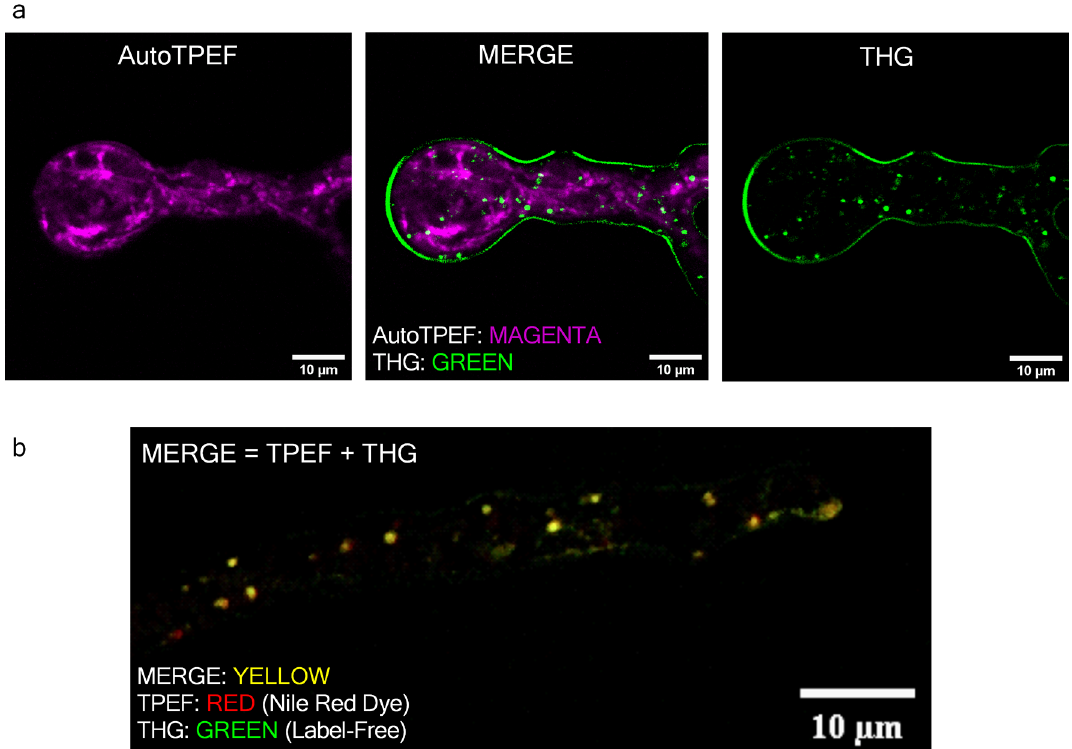
Figure 4. TPEF and THG images of Phycomyces blakesleeanus exponential growth phase hyphae in standard liquid medium show that the predominant source of spot wise THG signal are lipid droplets. ( a ) Merged autoTPEF and THG images of same unlabeled live hypha showing that there is no overlap of autoTPEF and THG signal. The average laser power at sample plane was 28 mW at 1040 nm (for THG) and 3.4 mW at 730 nm (autoTPEF). ( b ) In vivo colocalization of stained LDs imaged by TPEF and LDs imaged by THG modality. Average laser power at sample plane was 32 mW for both THG and TPEF at 1040 nm. Pearson’s correlation coefficient R total = 0.844 (ImageJ, The Colocalization Threshold plugin). All images were taken with Zeiss 40 × 1.3 oil objective